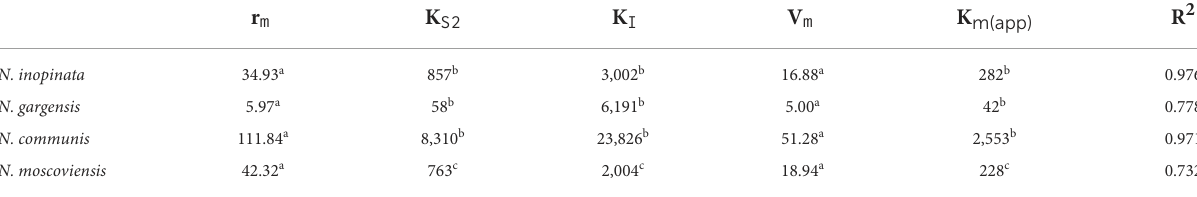
TABLE 2 Kinetic parameters of